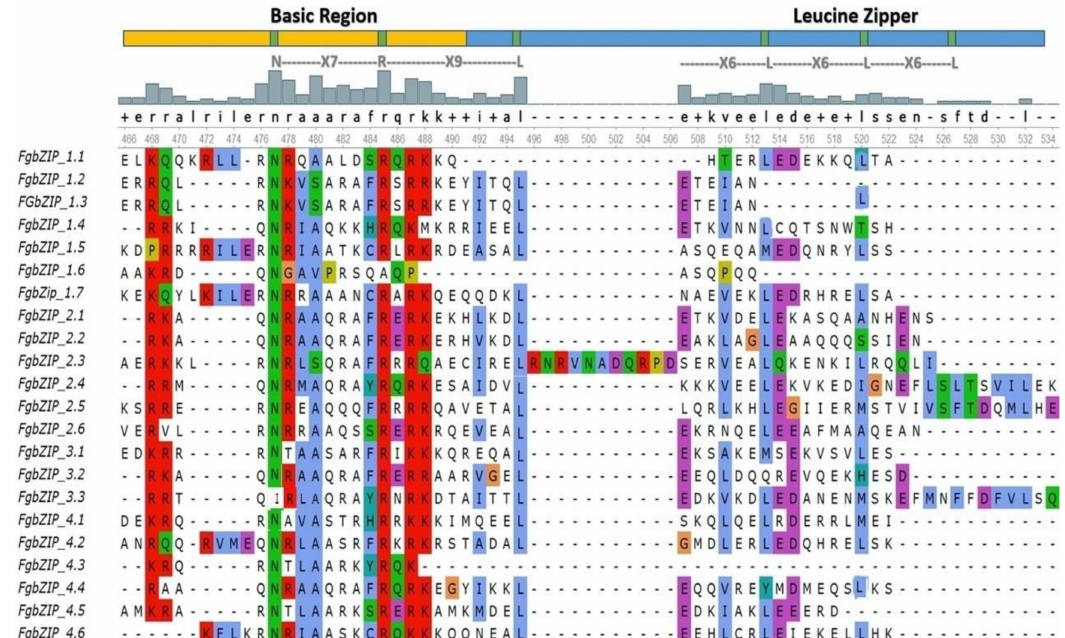
Figure 1. Multiple Sequence alignment of FgbZIP amino acids performed by MAFFT algorithm using UGENE. The representative model of both basic (yellow strip) and leucine zipper (blue strip) region are shown above by highlighting and labelling. Green, red and blue colored amino acids indicate conserved amino acid residues of bZIP gene family. While contrast colors in the conserved region depicts the position replaced by other less conserved amino